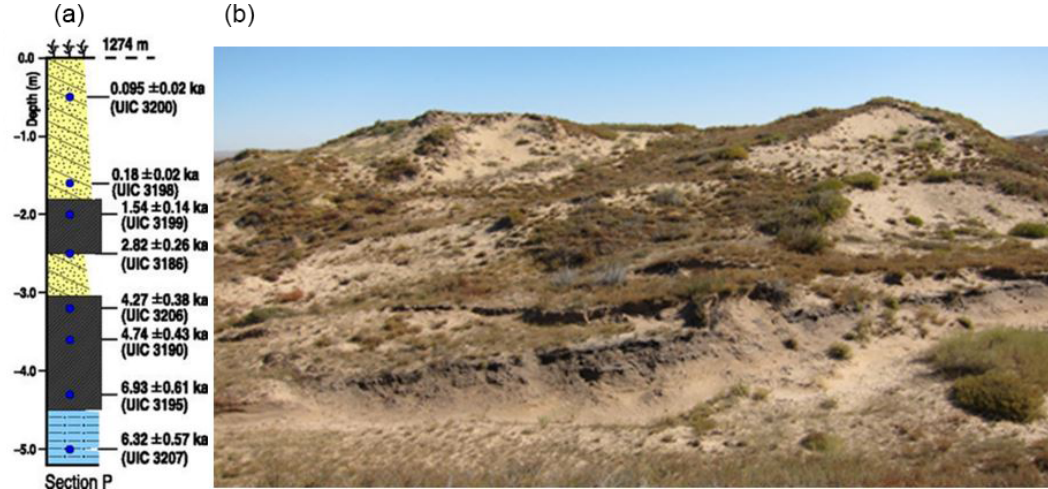
Figure 2. Southern Hunshandake. (a) Section P from Yang et al. (2015) showing paleosols and sandy units which overlie an earlier lacustrine unit. (b) Sampled exposure showing the two